Question: In a single sentence, describe what this figure presents.
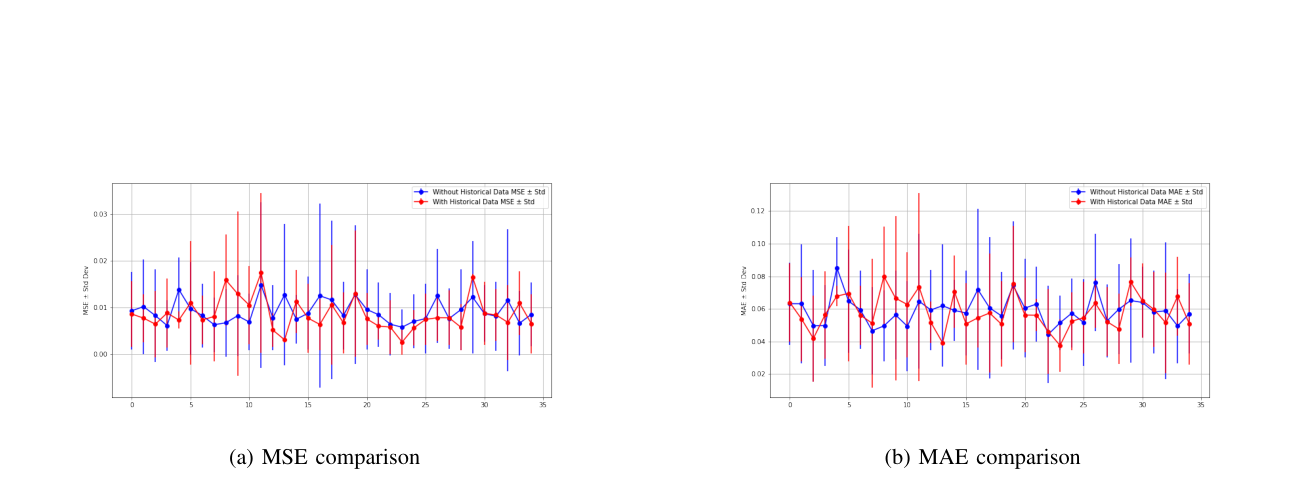
Answer: Comparison of MSE and MAE with Standard Deviation per Cluster for Cold Start vs Non-Cold Start scenarios. Note how cold-start values are comparable with the values with historical data.